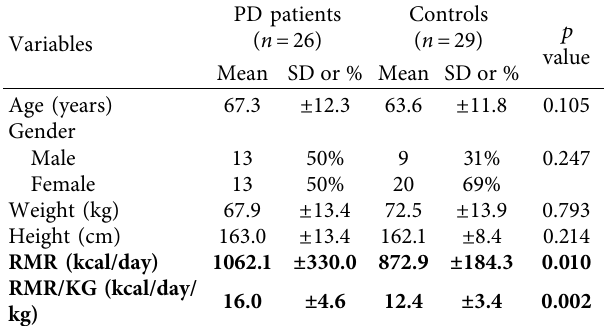
Table 3: RMR of PD patients and control subjects.